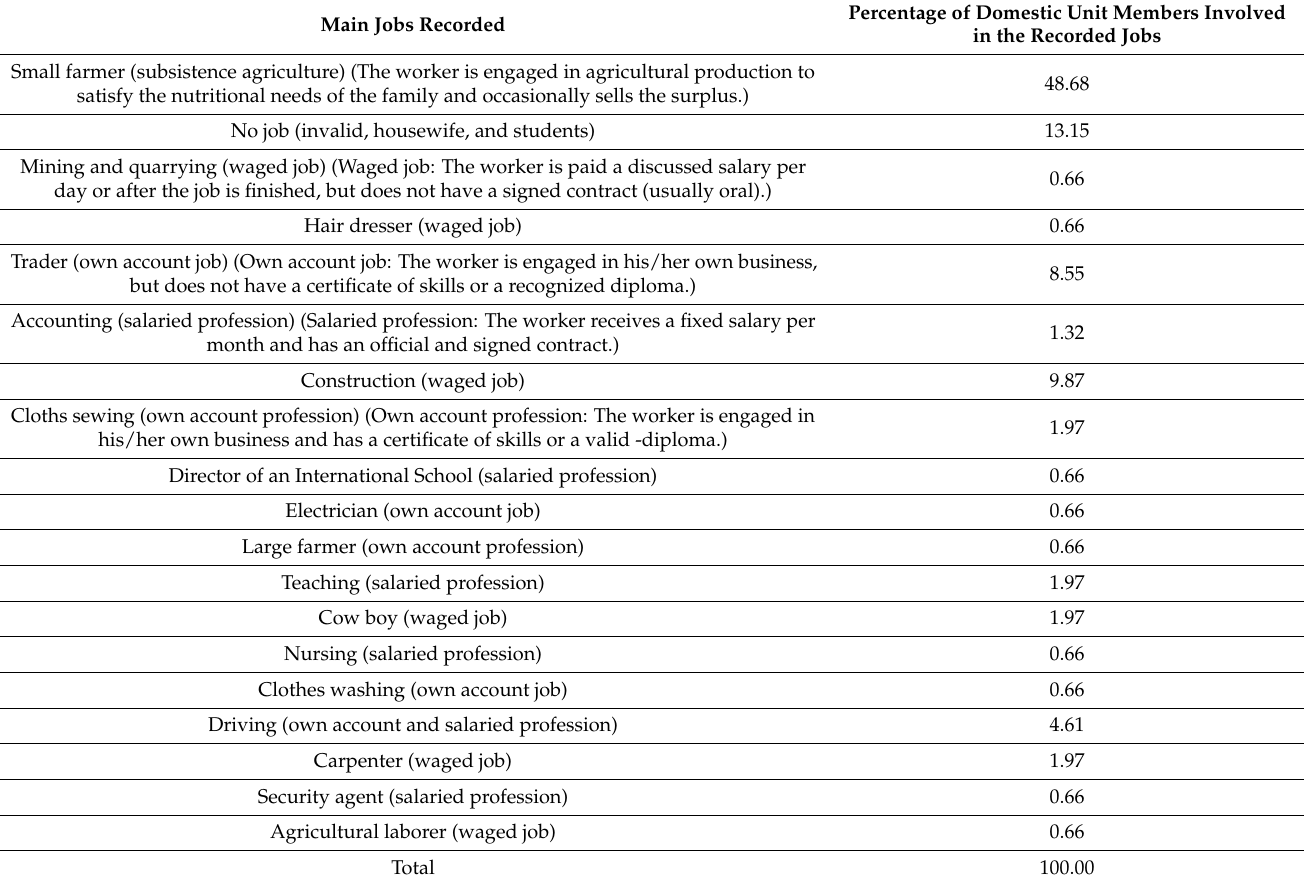
Table 3. Main jobs practiced by the adult members of domestic units. Main Jobs